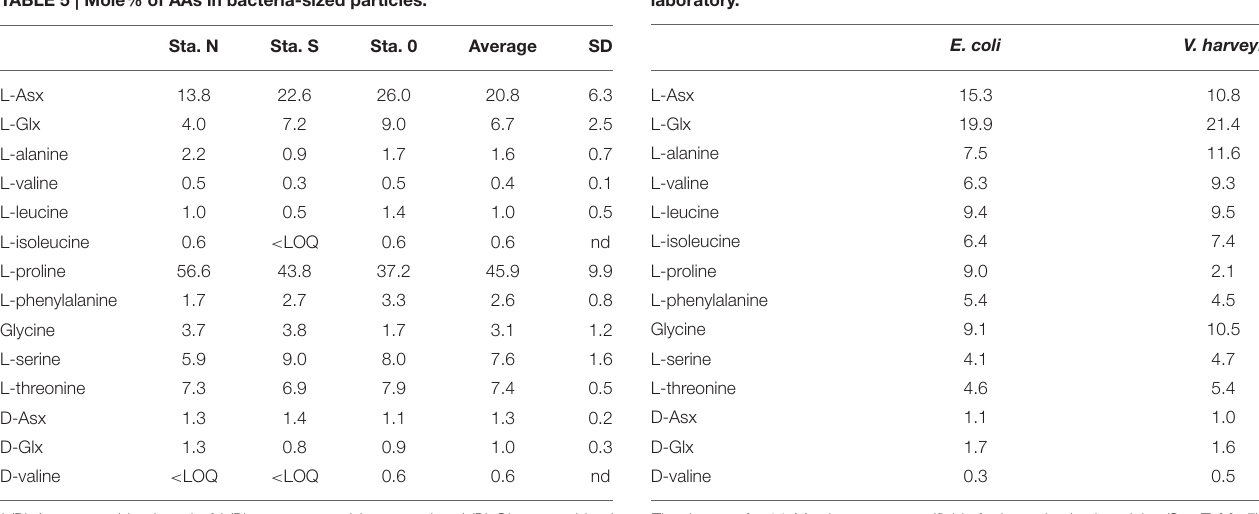
TABLE 5 | Mole% of AAs in bacteria-sized particles.